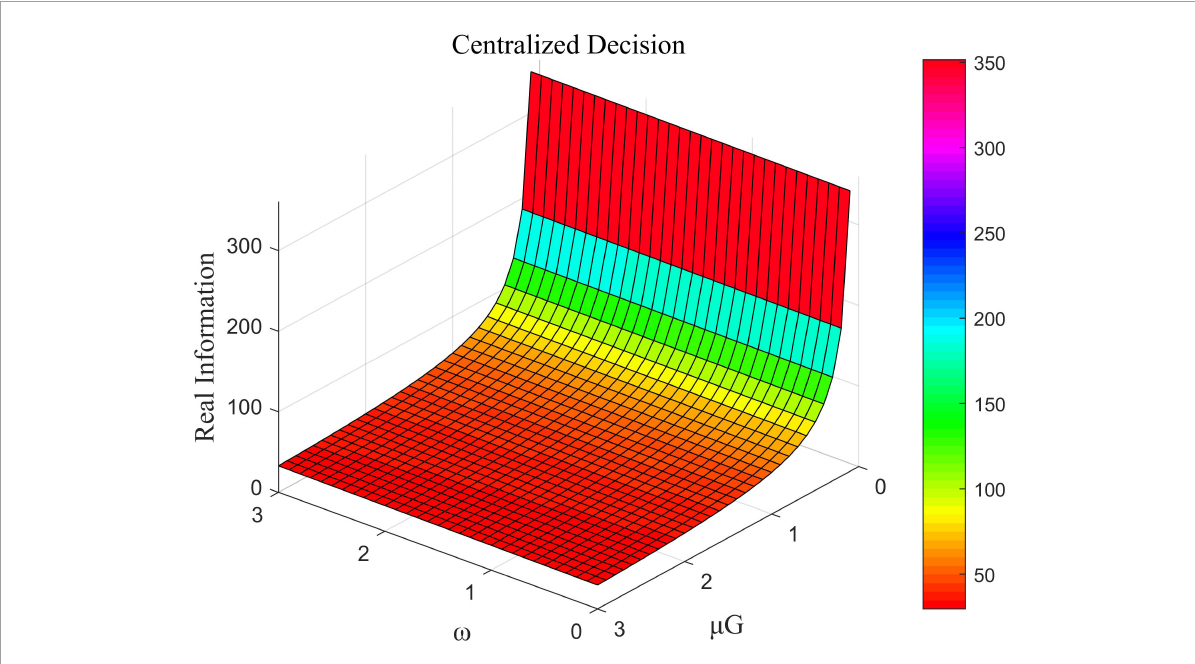
FIGURE7 The influence of ω and µ G on the total amount of real information under centralized decision-making.